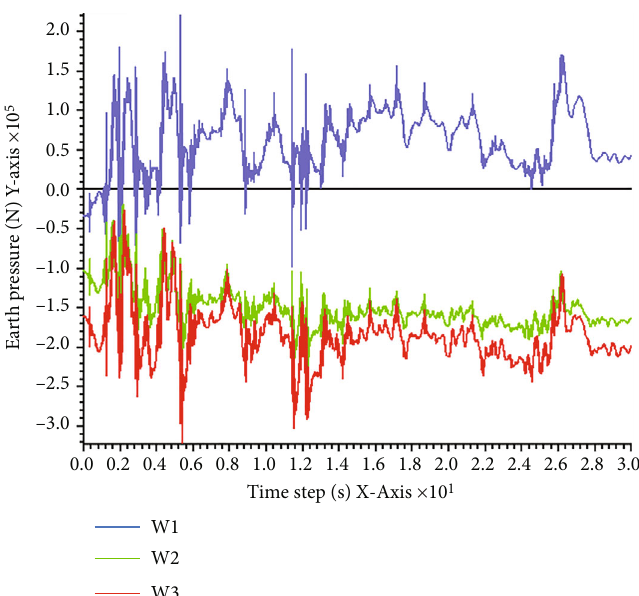
Figure 13: The time-course curve of the earth pressure behind the antislide pile No. 1.